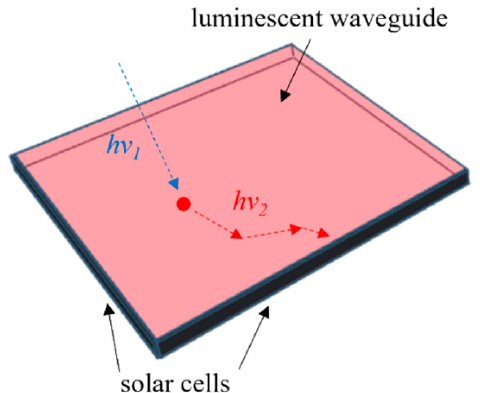
Figure 1. The operational mechanism of luminescent solar concentrators (LSCs).